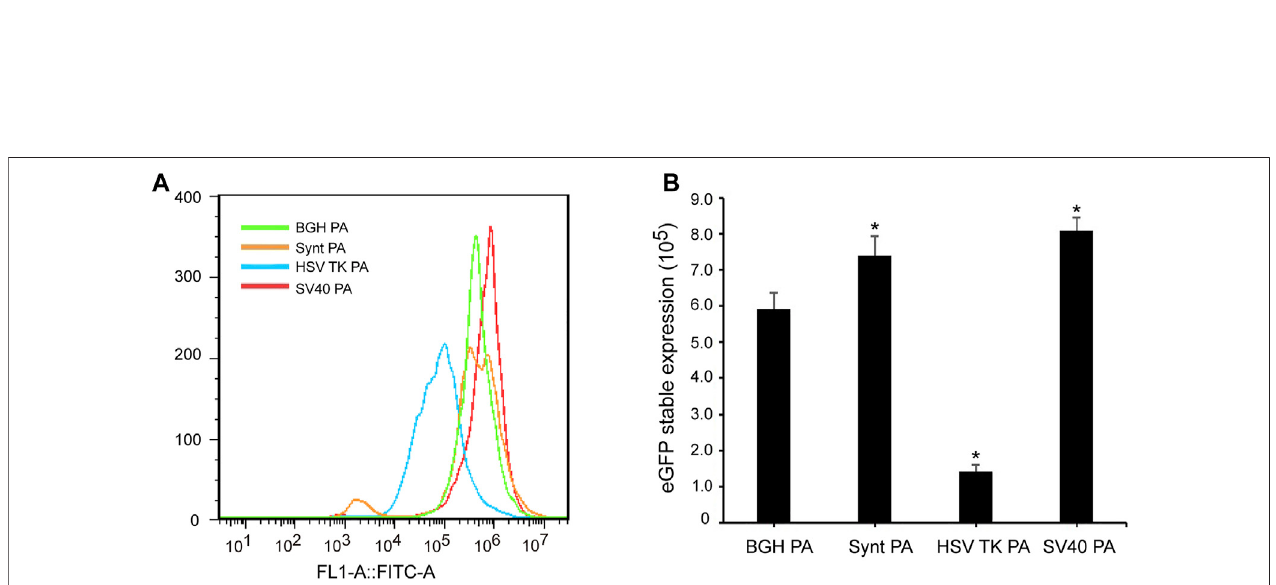
FIGURE 3 | Effect of different poly A containing vector on stable transgene expression. Cells were collected under G418 screening at 30 days post-transfection, recombinant protein expression was tested using fl ow cytometric analysis. (A) The mean fl uorescence intensity was measured by fl ow cytometry; (B) Analysis of eGFP stable expression. Error bars indicate standard deviation between triplicates. Compared with BGH poly A, p < 0.05.